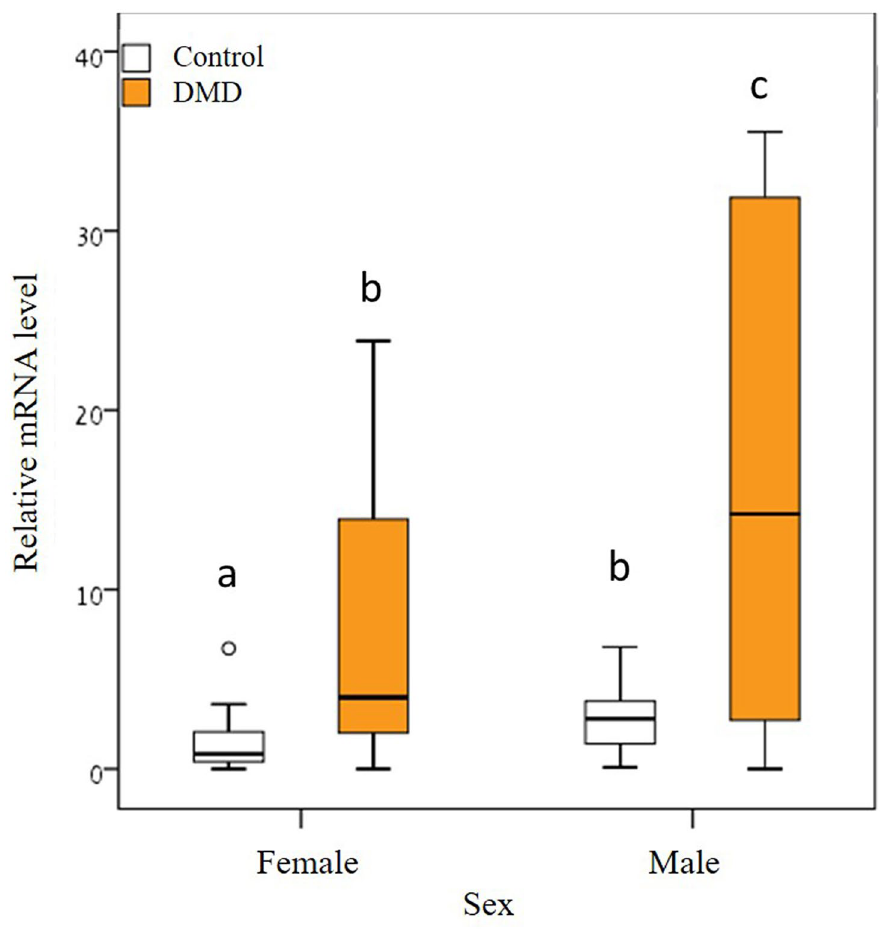
Figure 2. Tctim expression in male and female beetles in response to aggregation pheromone; DMD. The synthetic aggregation pheromone increased the expression of Tctim (significantly different bars carry different alphabets, Wilcoxon sign rank test, P ˂ 0.05). The box encompasses the interquartile range, the line across the box is the median, and the whiskers are drawn to the nearest value within 1.5 times the interquartile range. All remaining outlying points are marked with a circle. Four beetle heads of the same sex were pooled per